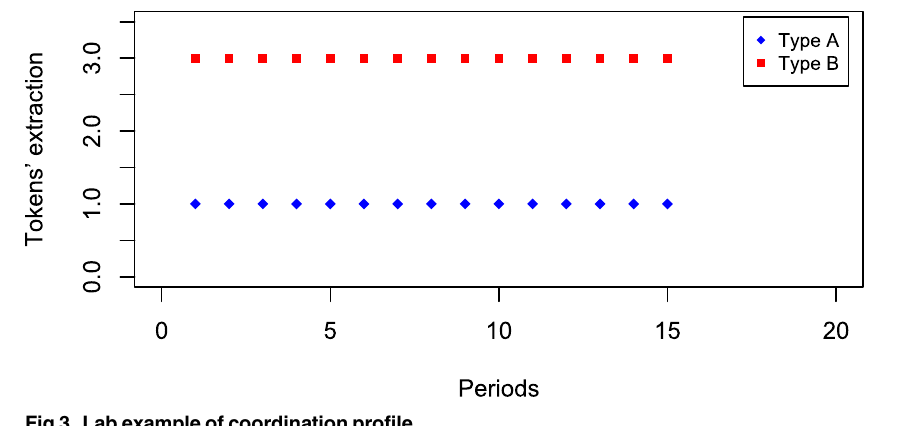
Fig 3. Lab example of coordination profile.